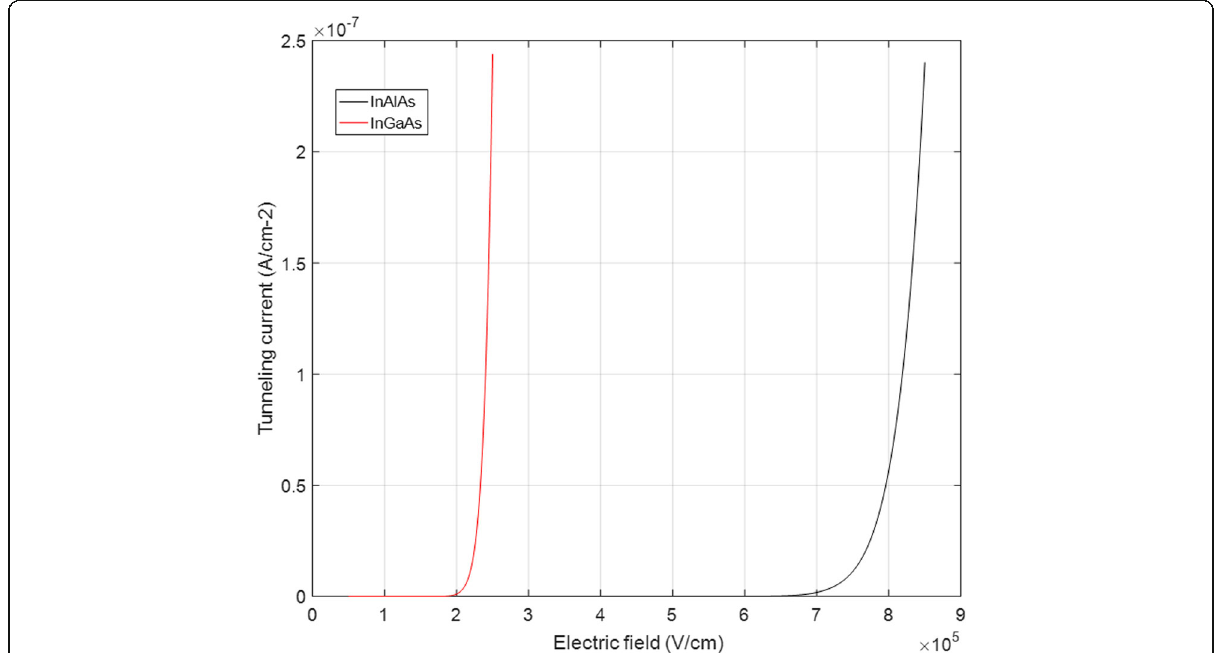
Fig. 2 Relationship between I tunnel / A and electric field in InGaAs and InAlAs. Presents the calculated results of I tunnel / A . I tunnel becomes significant at 2.0 × 10 5 V/cm of InGaAs and 6.9 × 10 5 V/cm of InAlAs,